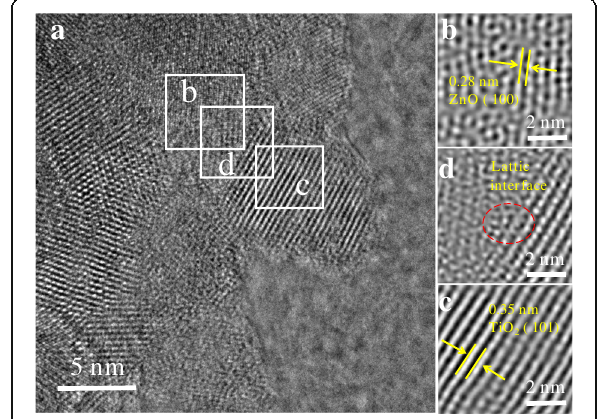
Fig. 3 a HRTEM images of ZnO@TiO 2 hollow spheres. b , c , and d are amplified HRTEM images of designated square part in a , indicating ZnO, TiO 2 , and ZnO@TiO 2 heterojunctions,